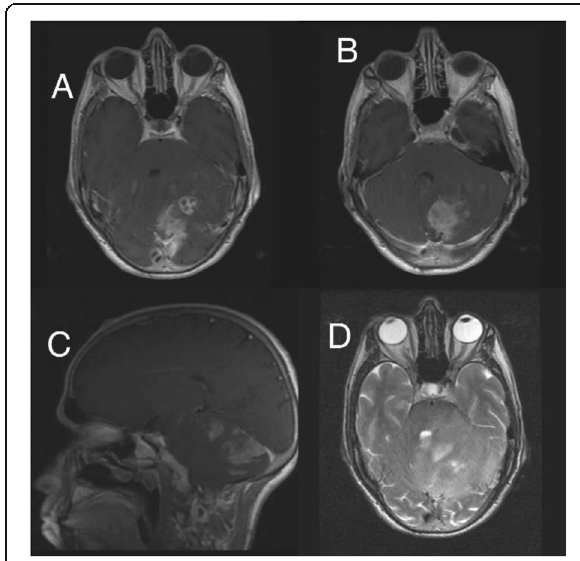
Fig. 3 a – c T1-weighted axial and sagittal MRI images showing two mass lesions in the left cerebellar hemisphere which show enhancement after gadolinium injection and d T2-weighted axial MR image showing severe peri-tumoral edema, all in favor of GBM